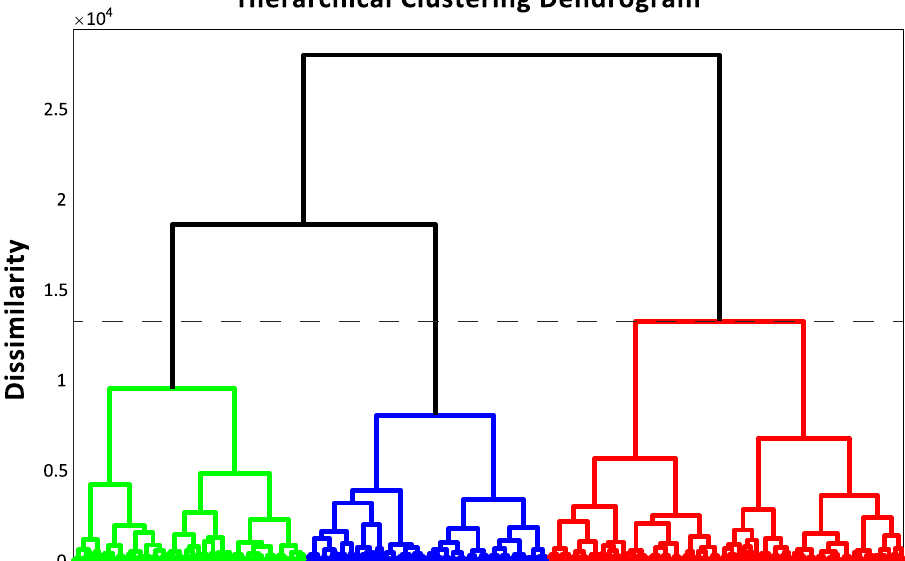
Figure 3. Psychological phenotyping in the general population Dendrogram from the hierarchical agglomerative clustering analysis of questionnaire items from the GAD-7, PSWQ, FFMQ Non-Reactivity Scale, and MAIA questionnaires in Study 2. Distinct colors (red, green or blue) indicate different clusters on the dendrogram (dashed line indicates stopping rule according to the maximal linkage distance).